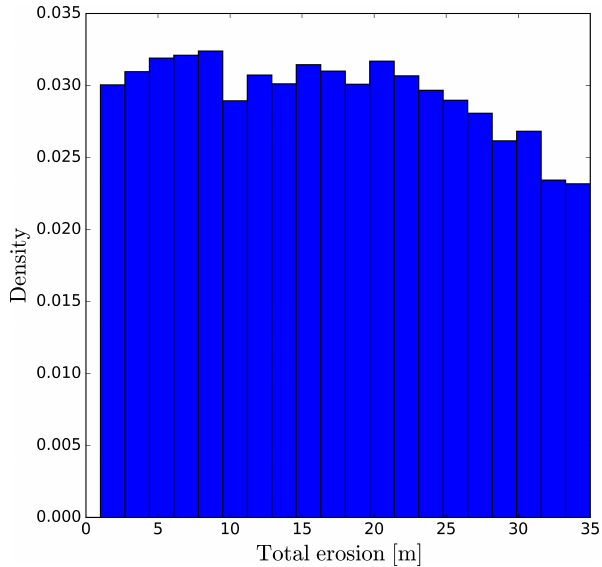
Figure 13. Derived posterior distribution for total erosion (denuda- tion) at the study site ( E × t